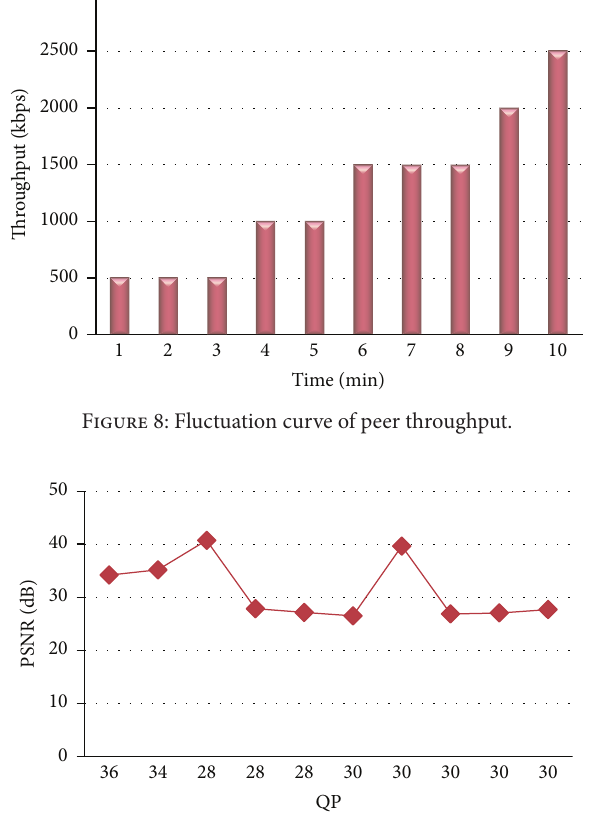
the playback does not need to stop and wait for unavailable blocks. Consequently, the number of stalls can be reduced during the